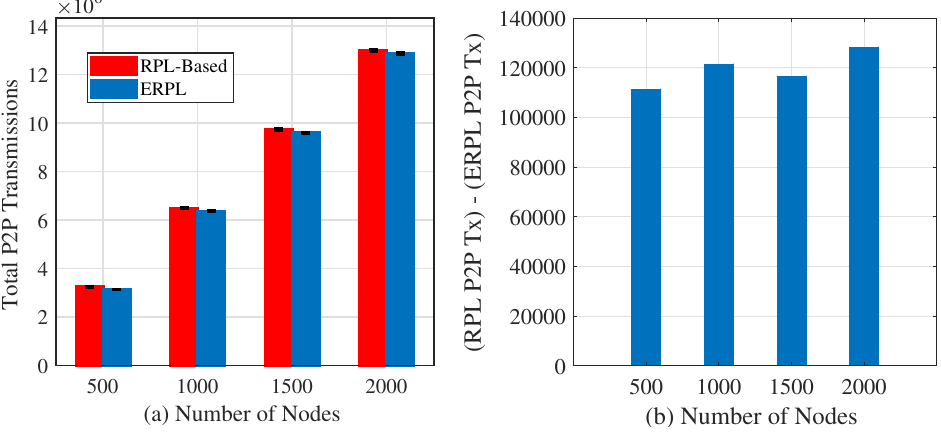
Figure 4. P2P Transmissions